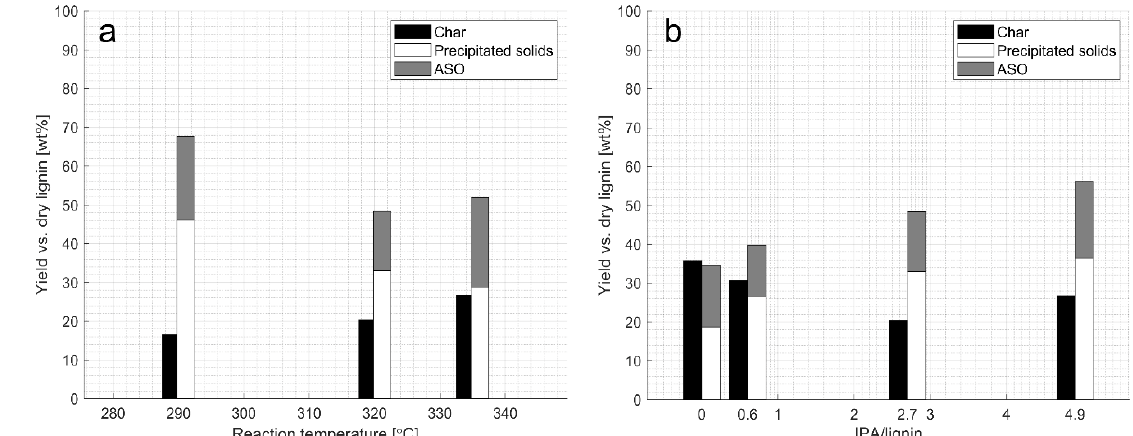
Figure 4. Yields obtained of the three product fractions vs. the dry lignin loaded in each reactor run: temperature series ( a ) and IPA series ( b ).